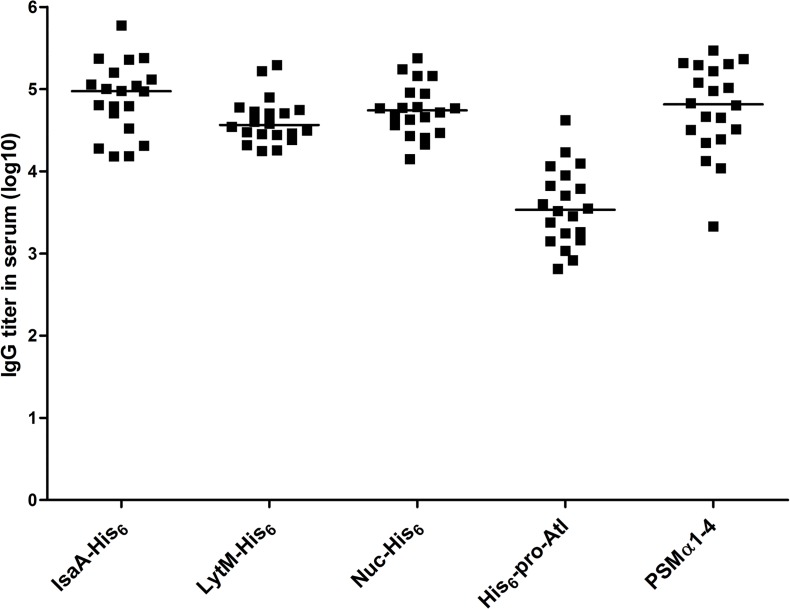
IgG titers in serum of mice after immunization with the octa-valent mixture.Mice (n = 20) were immunized subcutaneously with the mixture containing IsaA-His6, LytM-His6, Nuc-His6, His6-pro-Atl, and PSMα1-4 at days -70 (5 μg of each antigen), days -42, and -14 (25 μg of each antigen). IgG titers on day -1 were assessed. Each symbol represents a single mouse. Median values are indicated by horizontal lines.